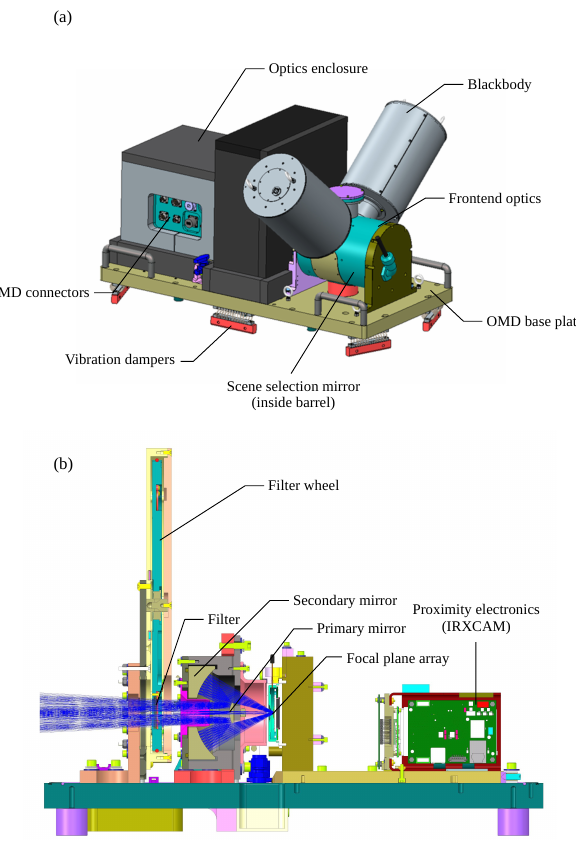
Figure 1. (a) Overview of the FIRR optomechanical device. The base plate dimensions are 90 × 44cm. (b) Section view of the optics enclosure.